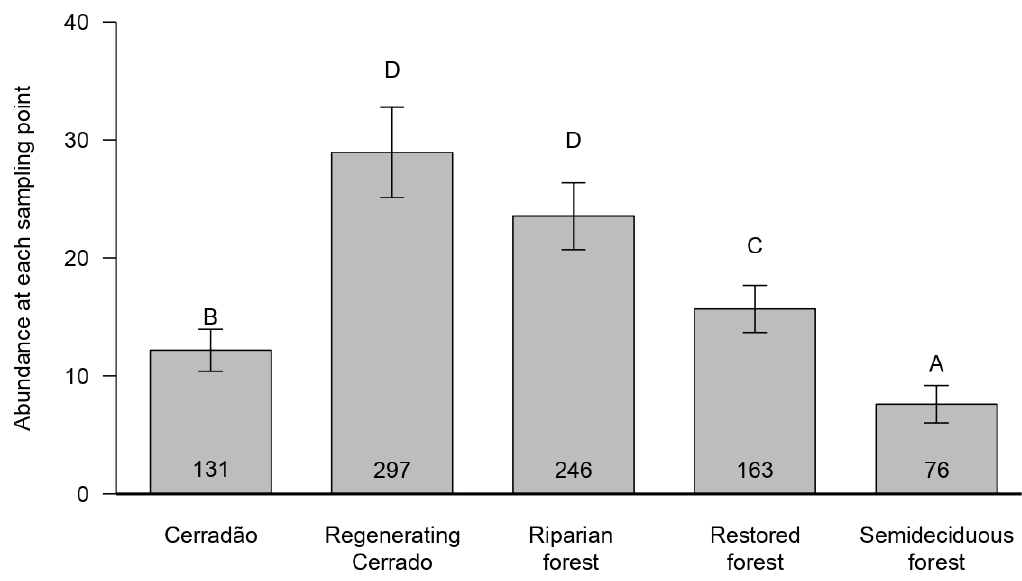
Fig 2 . Abundance of social wasps collected for each point in each type of vegetation. The number inside the bars indicates a total abundance for each vegetation. Different capital letters represent significant differences.